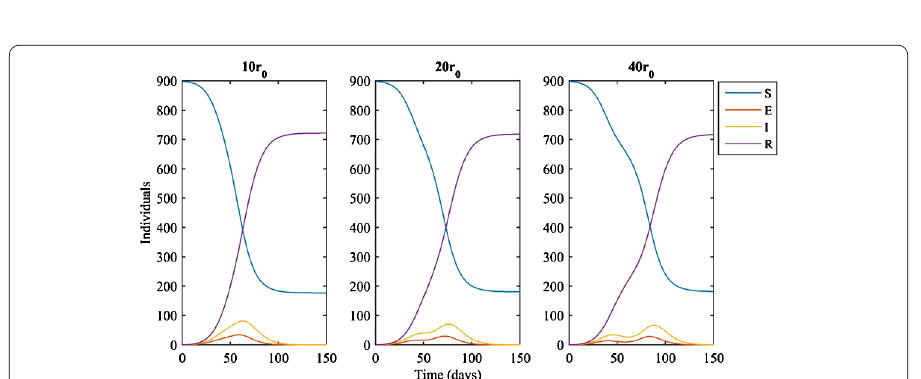
Figure 4 Dynamics of populations with varying number of patches ( R 0 = 2, C =